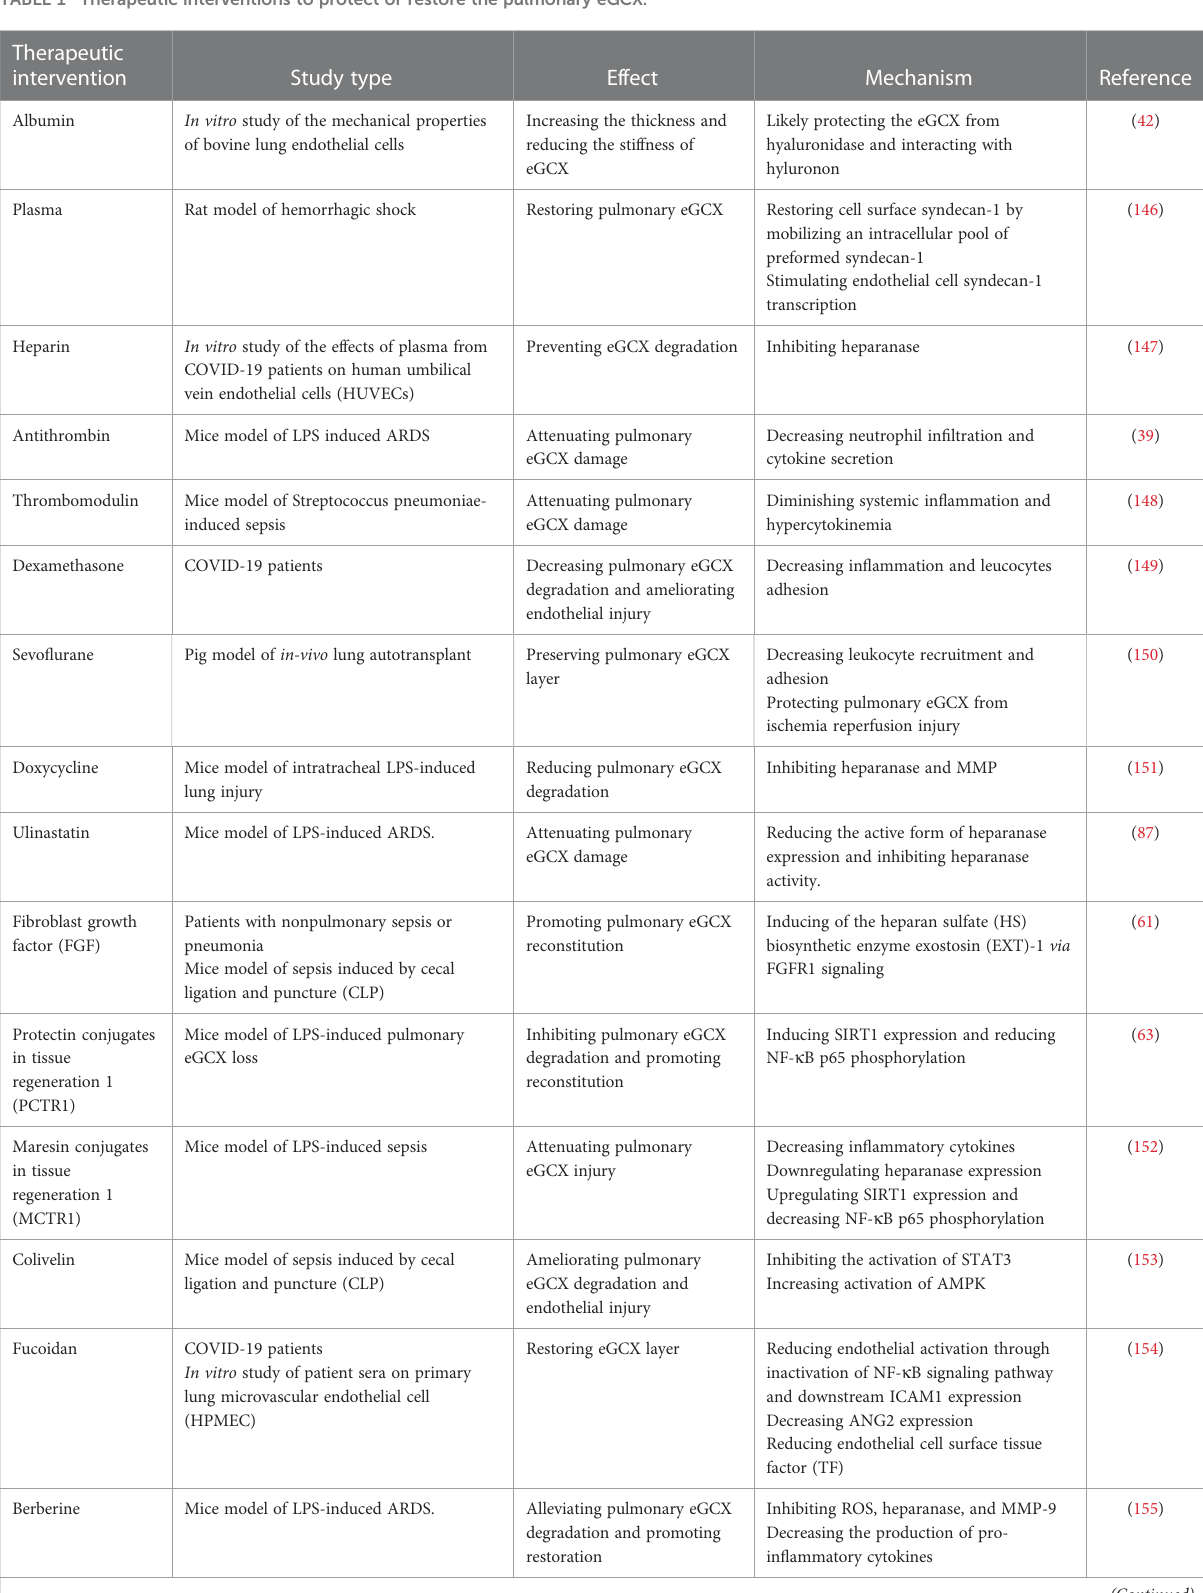
TABLE 1 Therapeutic interventions to protect or restore the pulmonary